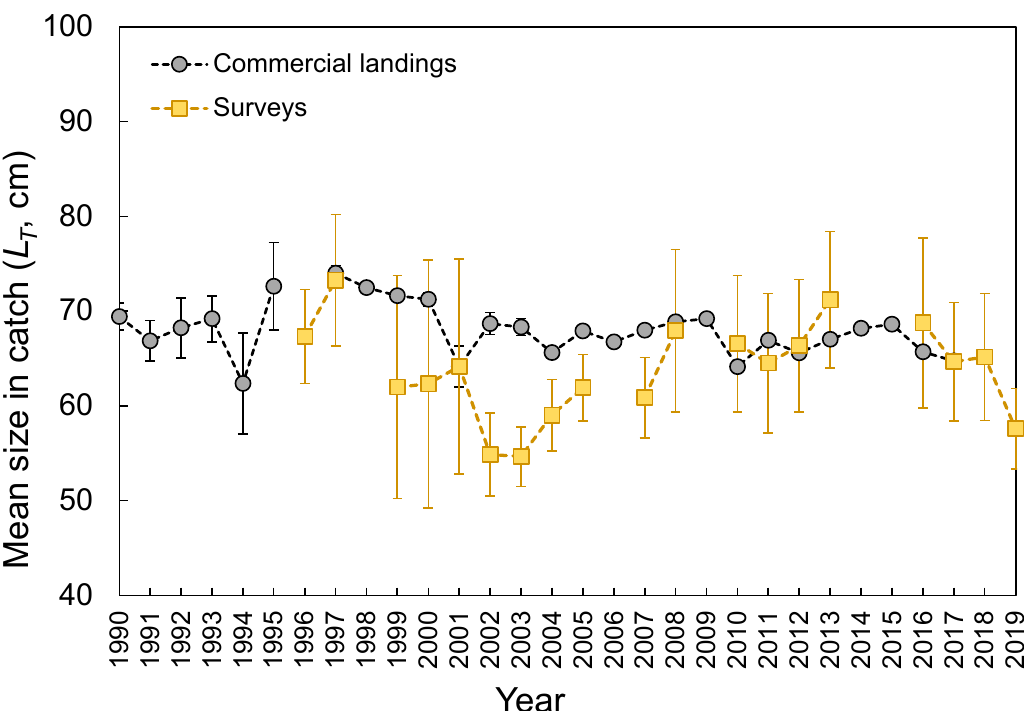
Figure 5. Annual mean (±0.95 confidence interval) of total length ( L T ) of the thornback ray Raja clavata caught during scientific surveys (1996 – 2019) and official commercial landings (1990 – 2017) in the Azores.